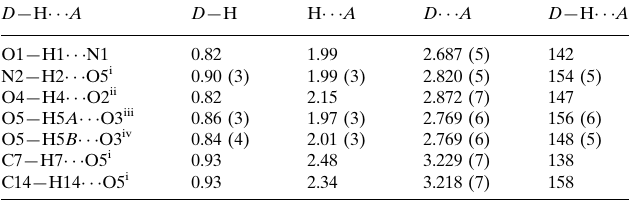
Related literature